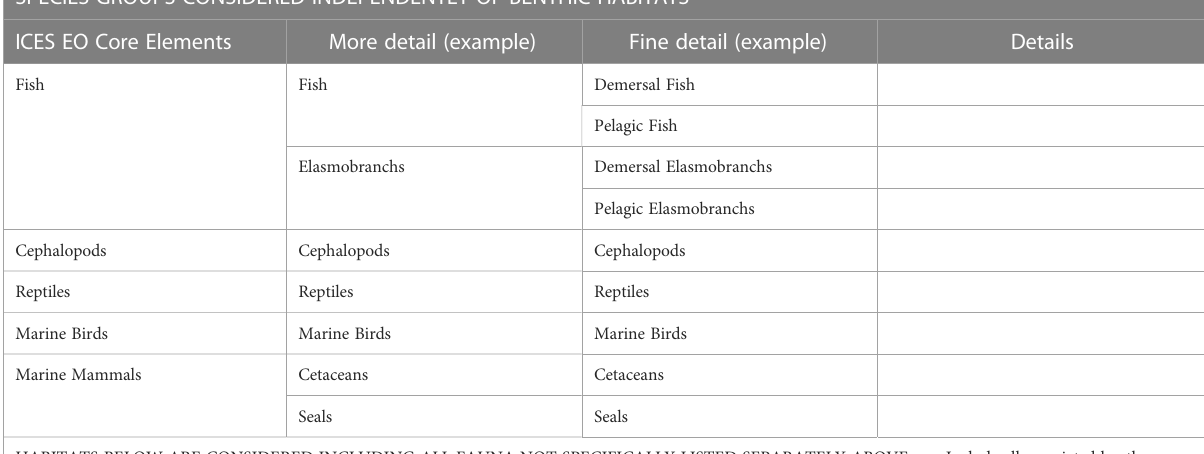
TABLE 9 Example hierarchy for carrying out detailed analyses and summarising to the coarse categories required for the ICES Ecosystem Overviews. SPECIES GROUPS CONSIDERED INDEPENDENTLY OF BENTHIC